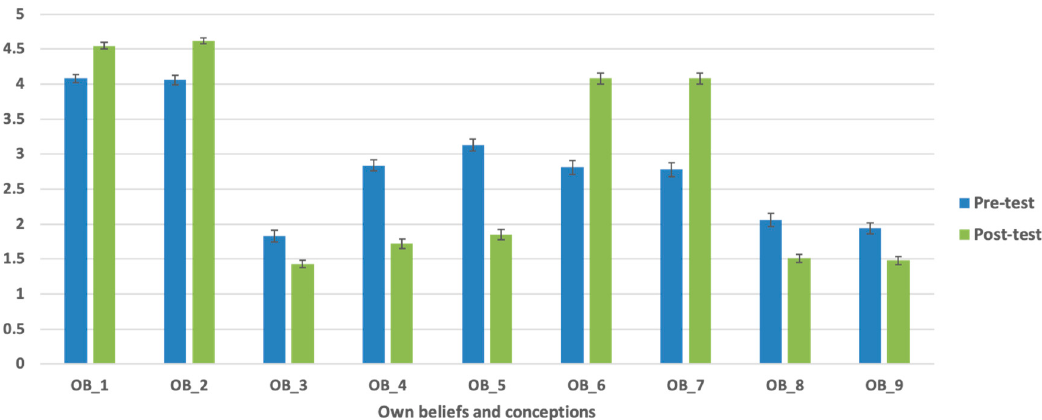
Figure 3. Mean values of the scores given for the pre- and post-test questionnaire by the 143 participants for the PSTs own beliefs and conceptions (OB) toward mathematics learning by the flipped-OCN method.